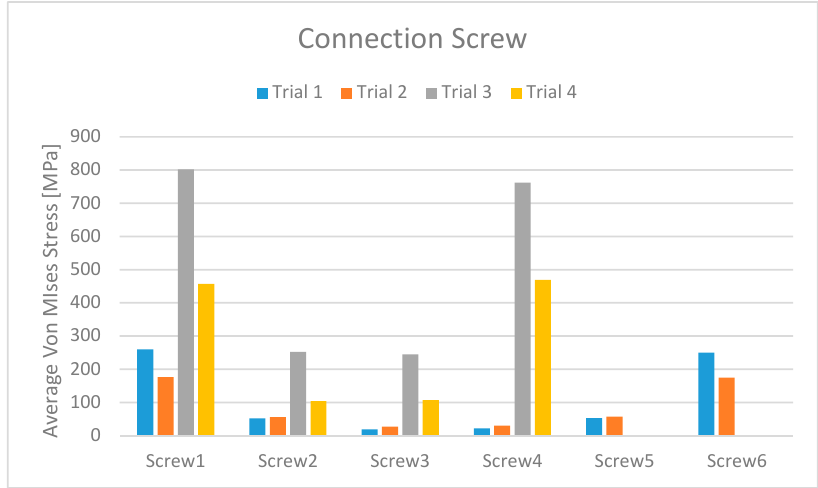
Figure 12. Dental implant stress maximum value for each trial and for the different screws.